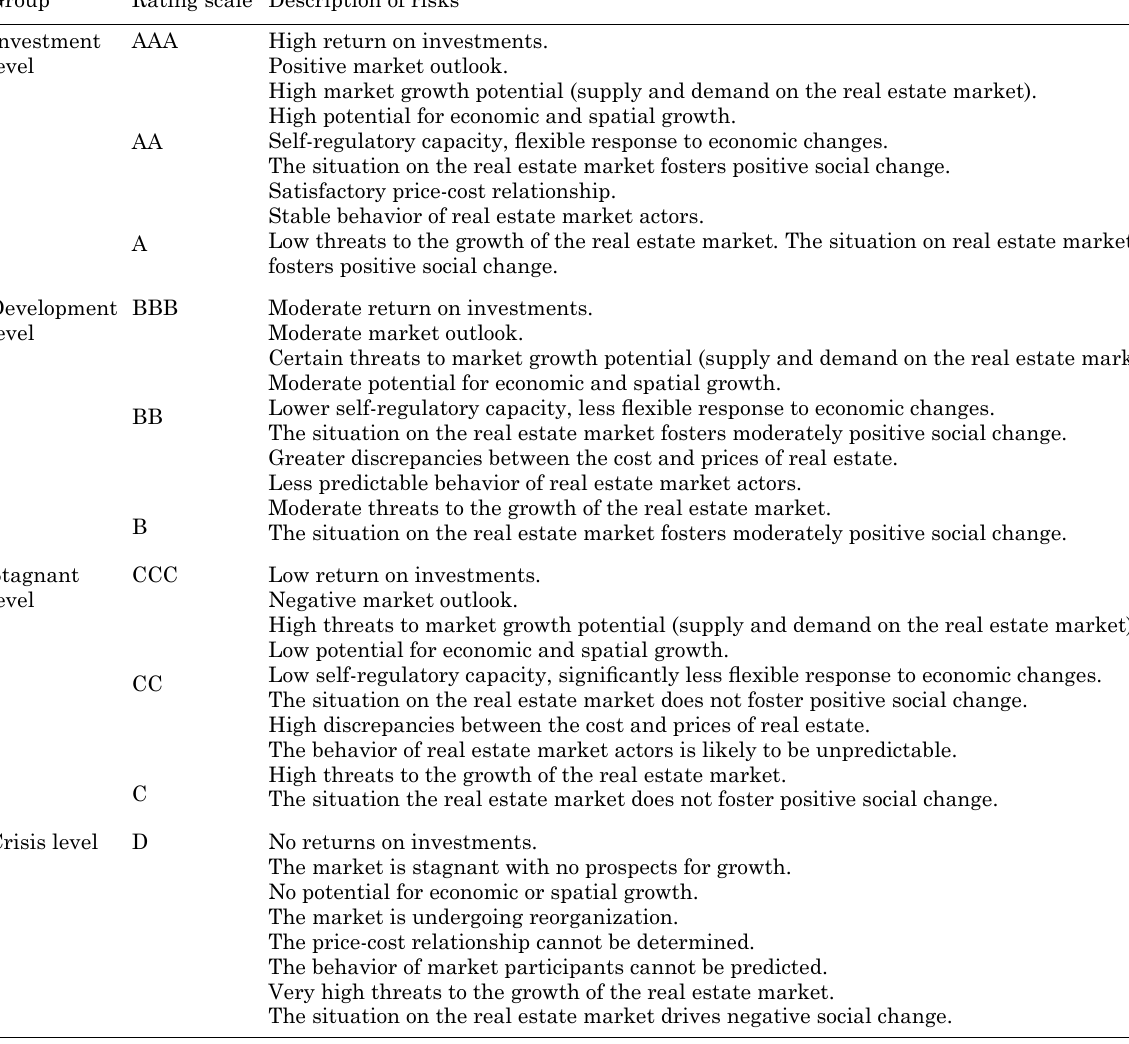
Table 1. Rating scale for classifying real estate markets